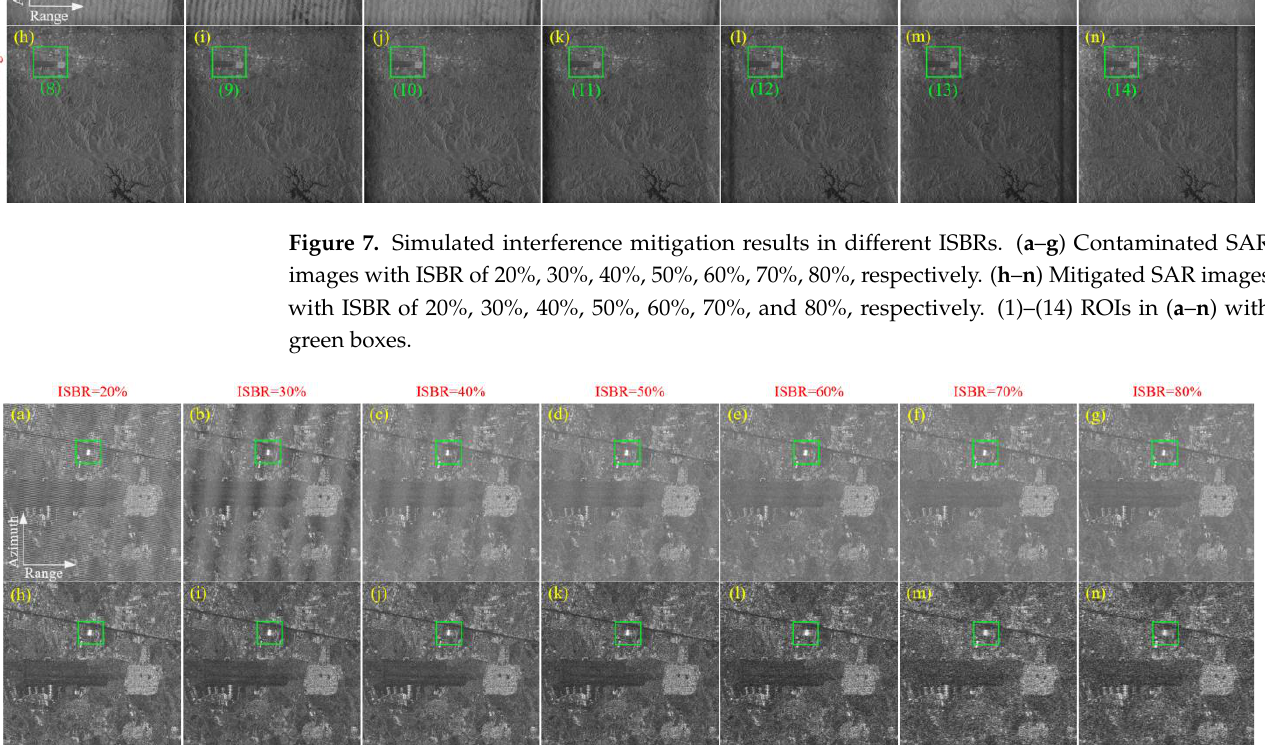
Figure 7. Simulated interference mitigation results in different ISBRs. ( a – g ) Contaminated SAR im- ages with ISBR of 20%, 30%, 40%, 50%, 60%, 70%, 80%, respectively. ( h – n ) Mitigated SAR images with ISBR of 20%, 30%, 40%, 50%, 60%, 70%, and 80%, respectively. (1) – (14) ROIs in ( a – n ) with green boxes.